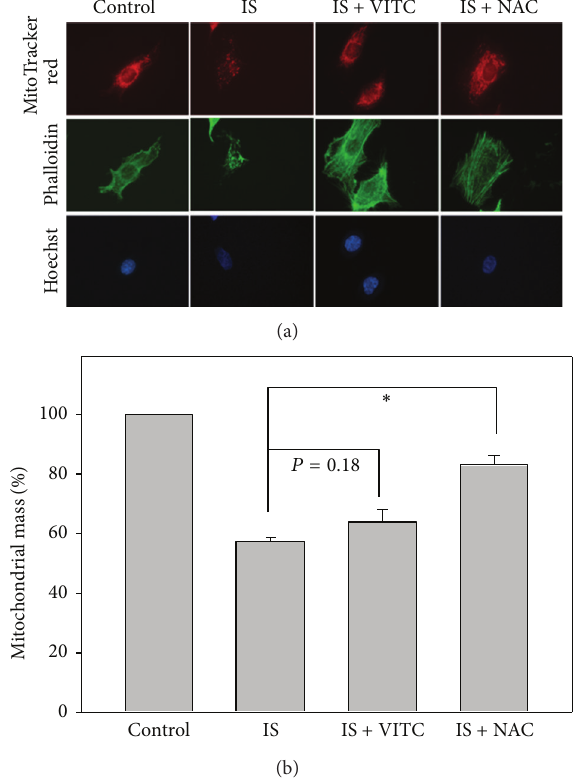
Figure 5: Role of antioxidants in IS-induced mitochondrial mass changes in HUVECs. Cells were treated with IS 125 𝜇 g/mL alone as the positive control, cotreated with IS 125 𝜇 g/mL and vitamin C 200 𝜇 M or NAC 10mM for 48 h. Cells without IS treatment were regarded as the negative control. The fluorescent dyes and colors were MitoTracker (red), phalloidin (green), and Hoechst 33258 (blue). (a) Representative confocal microscopy. (b) Quantification analysis of relative mitochondrial mass (% of control). Data, mean ± SD ( 𝑛 = 2 ). ∗ 𝑃 < 0.01 compared to the IS